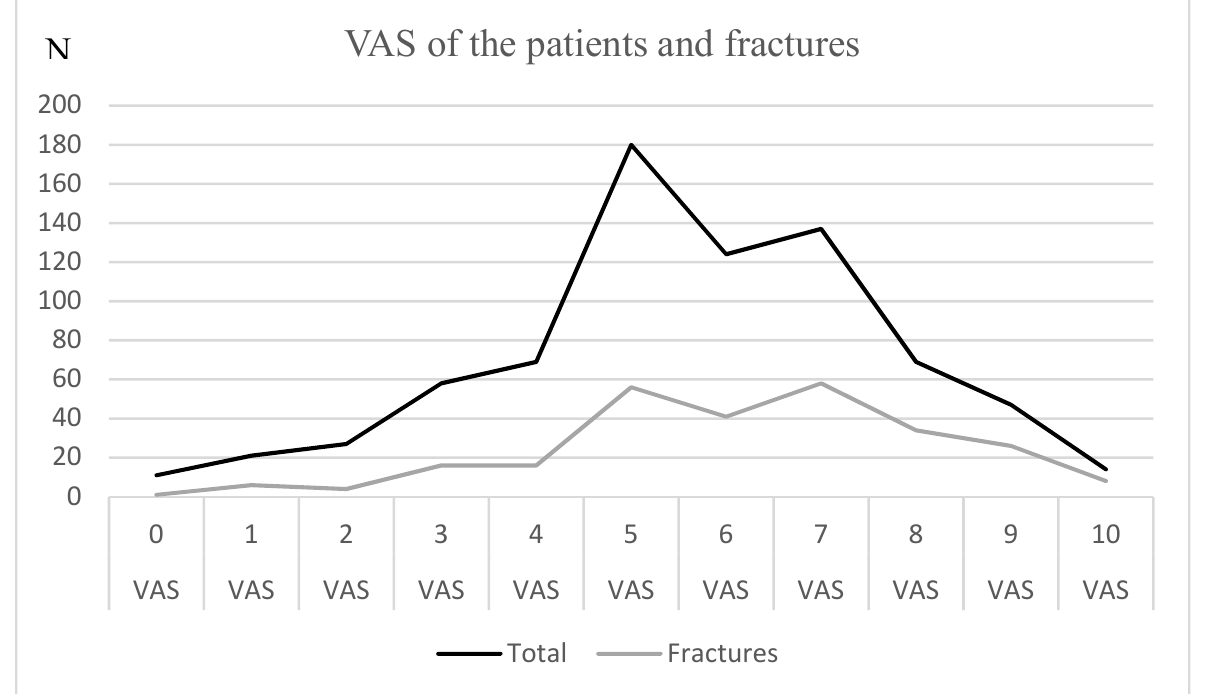
The onset of pain showed no significant difference between patients with and without fractures (Table